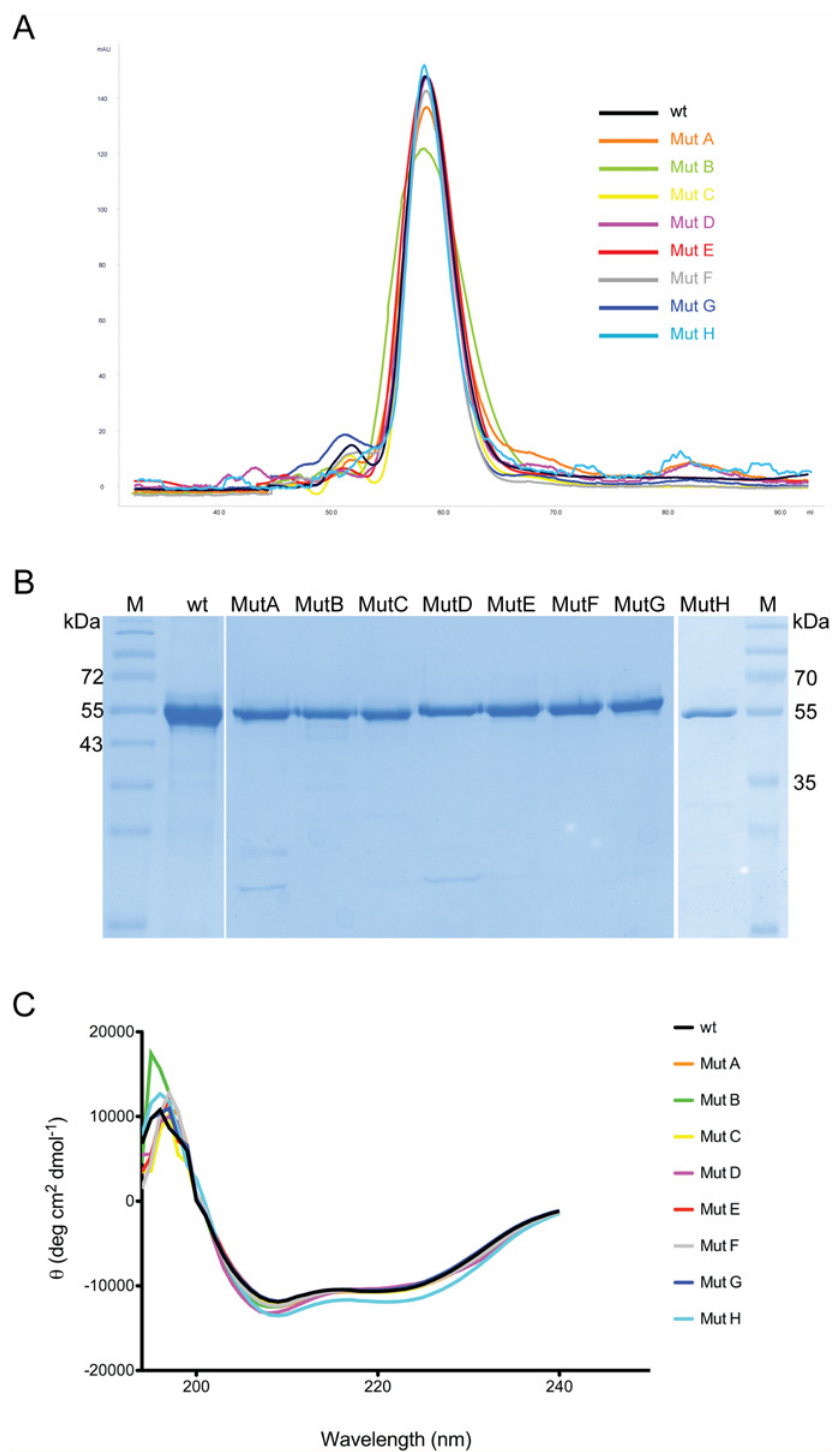
Fig 2. Expression of recombinant proteins in E . coli . A) Size exclusion chromatogram showing monomeric nature of wt and mutated proteins. B) The purity and quality of the mutants was assessed by electrophoresis: 2 μ g of wt and mutant proteins were run on 12% SDS-PAGE gel under reducing conditions and stained with Coomassie. C) Far CD spectra of the proteins studied herein, showing nearly identical secondary structures for all the mutants. For color coding and mutation see Table